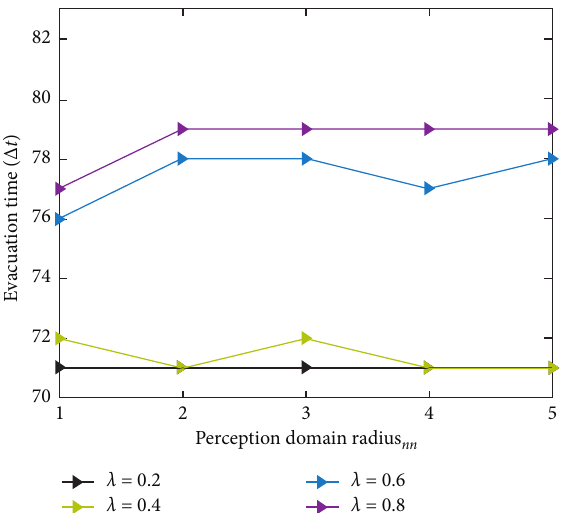
Figure 16: Total evacuation time with different perception domain radius in scenario 3 ( β � 0 . 67, c � 0 .